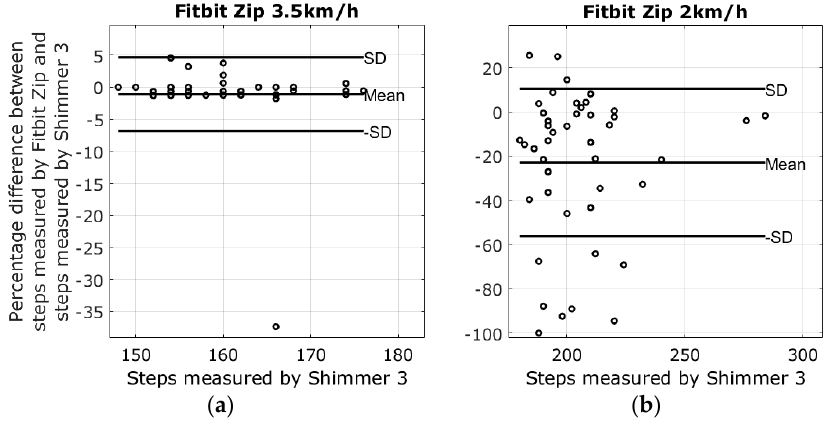
Figure 6. Results from the walking tests with plots showing the difference between the steps measured by the Fitbit Zip and the Shimmer 3. ( a ) The percentage error of the 3.5 km/h walking test is − 1.1 ± 5.8; ( b ) The percentage error of the 2 km/h walking test − 22.9 ± 33.3.